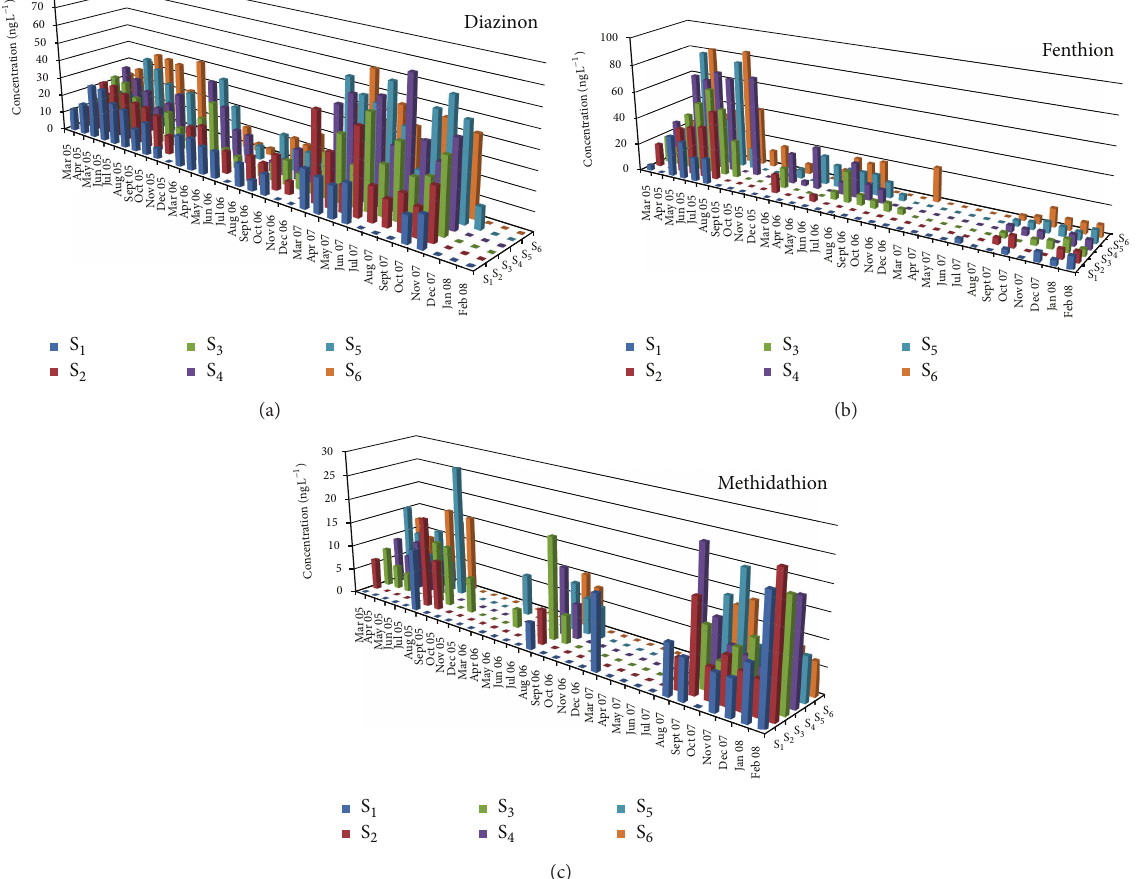
Figure 3: Temporal and spatial distribution of selected insecticide (diazinon (a), fenthion (b), and methidathion (c)) concentrations during the sampling period (March 2005–February 2008) for the six sampling sites.